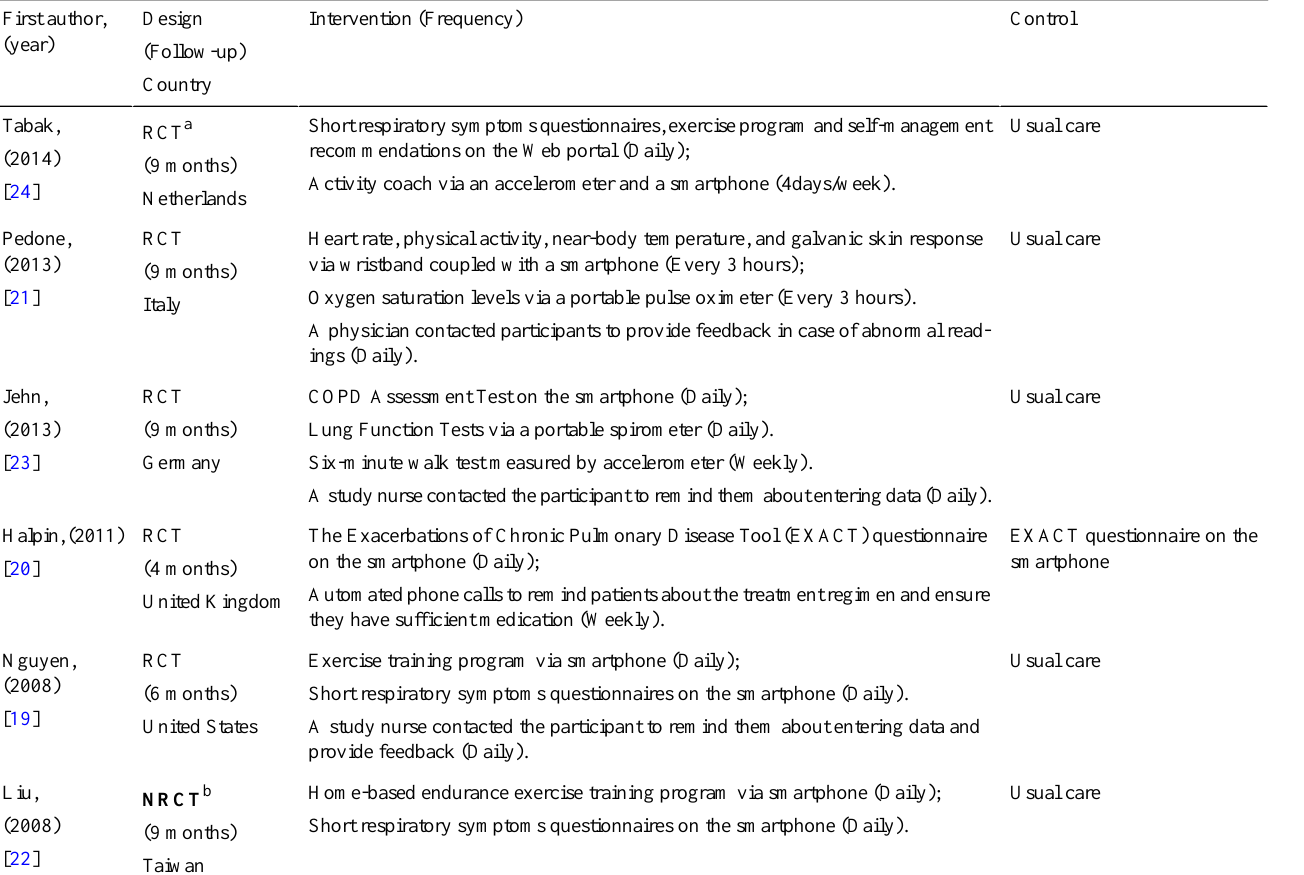
Table 3. Summary of the methodology in studies using smartphone interventions with COPD patients.